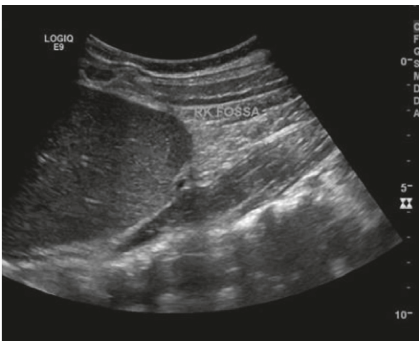
Figure 1: Long-axis/sagittal ultrasound image from the right upper quadrant showing no evidence of renal parenchyma.